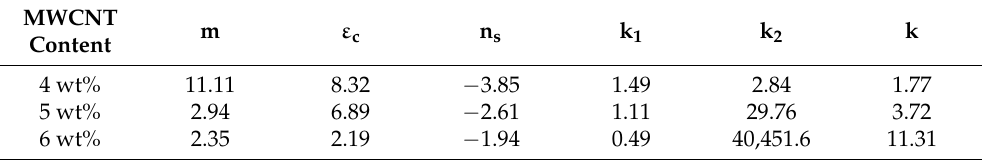
Table 2. ∆ R/R 0 parameters after strain curve fitting for the different MWCNT/VMQ-DCP composites. MWCNT